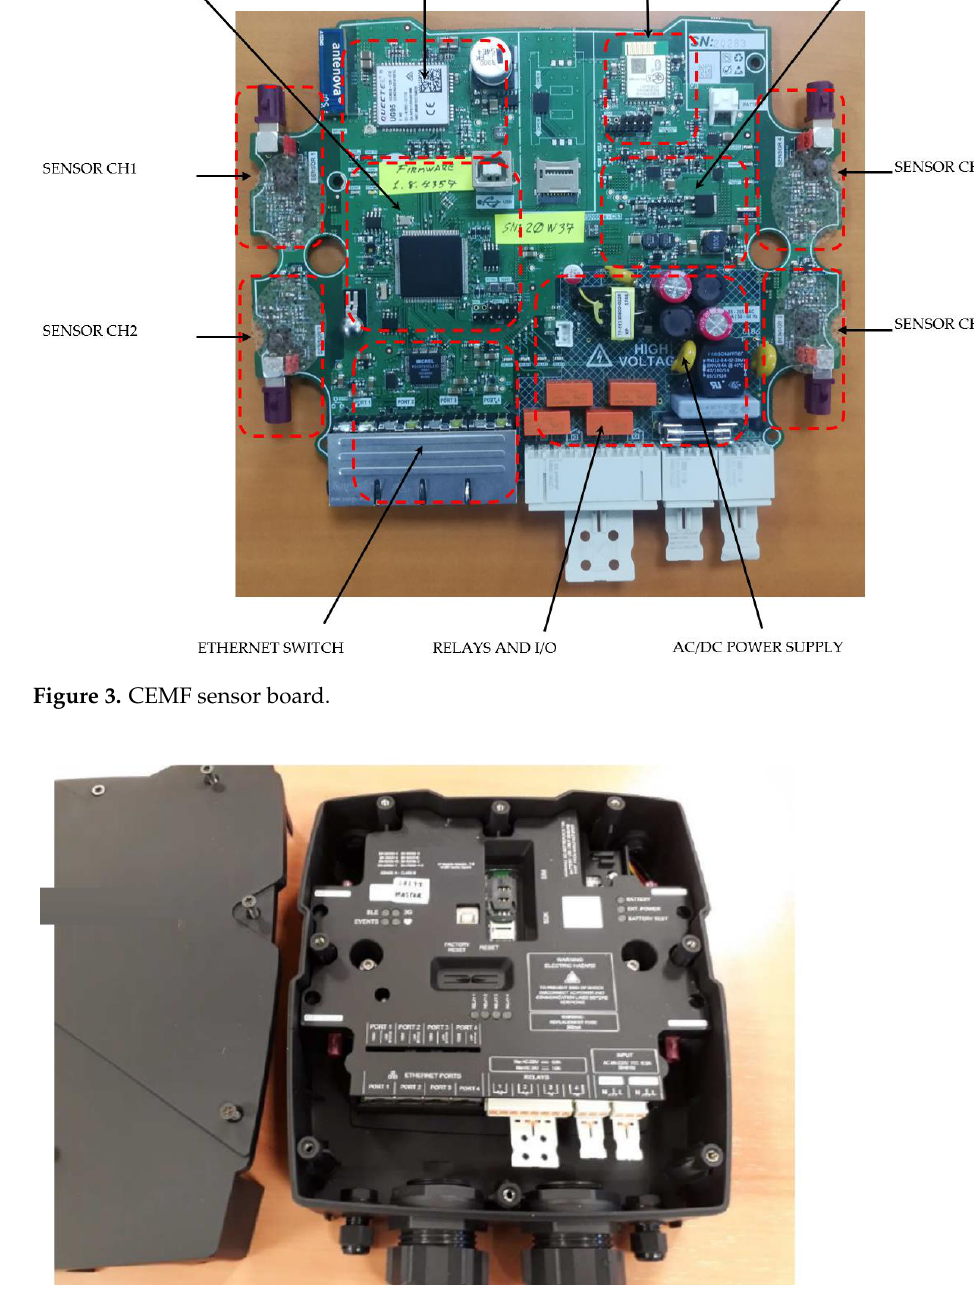
Figure 4. CEMF sensor inside its enclosure.